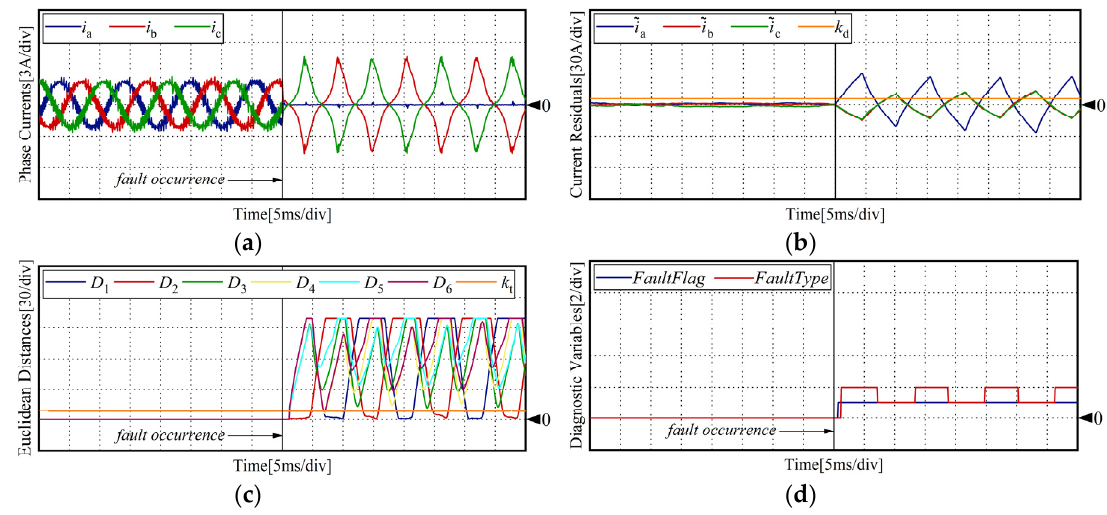
Figure 17. Test for A-phase OC fault at a reference speed of 1400 r/min: ( a ) phase currents*;. ( b ) current residuals; ( c ) Euclidean distances; ( d ) diagnostic variables.